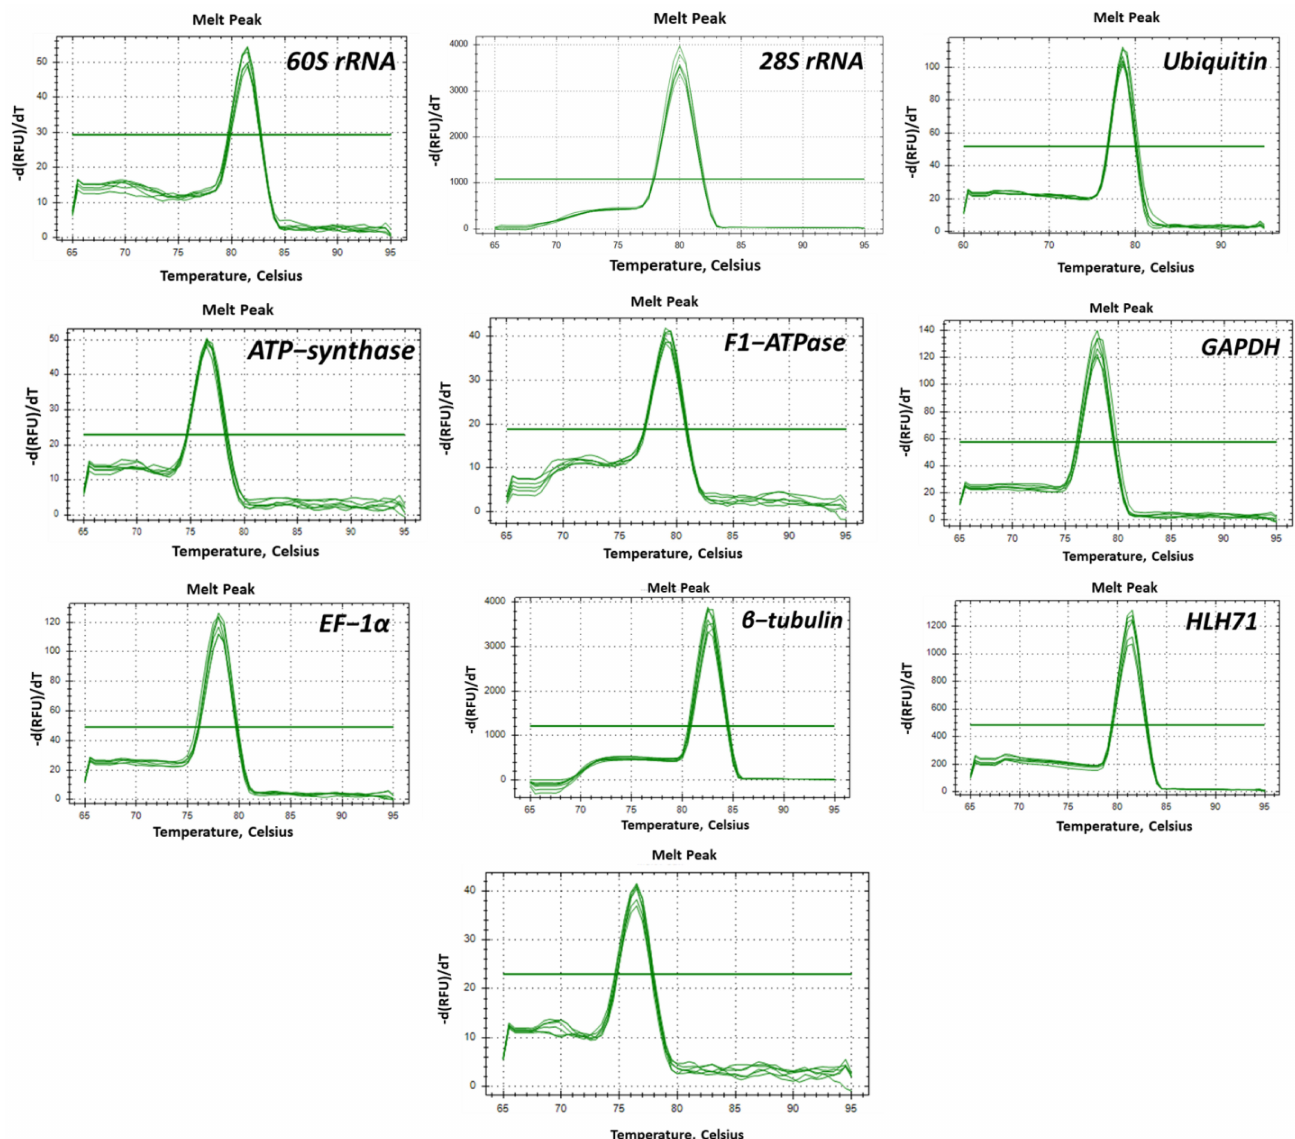
Figure 3. Melting curve of the candidate